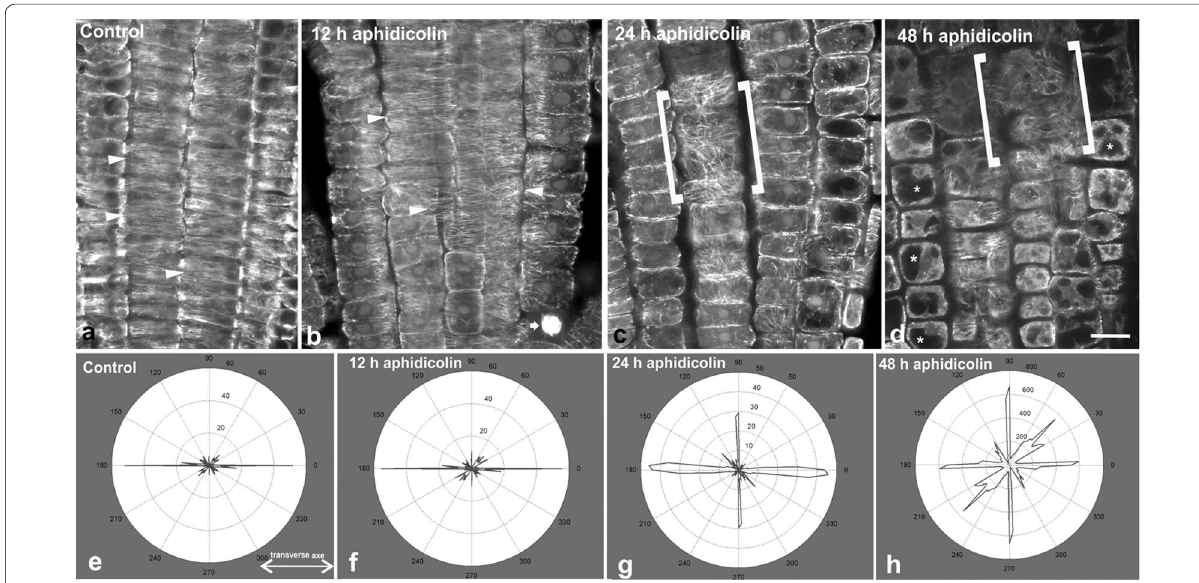
Fig. 1 Cortical microtubule orientation in the meristematic zone of untreated ( a ) and aphidicolin‑treated ( b – d ) roots. Single CLSM sections through the boundary between protoderm and cortex are presented, so that in the center of each figure cortex cells can be observed. In all the images of this work the root tip is oriented towards the bottom of the page. In control root ( a ) prominent transverse orientation of cortical microtubules can be observed in interphase cells (arrowheads). At 12 h of treatment ( b ) transverse microtubule orientation persists (arrowheads), while dividing cells still exist (arrow points to a mitotic cell). After 24 h of treatment ( c ), cell divisions have ceased and cortical microtubules exhibit random orientation (cells within the brackets are cortex cells viewed at external cortical plane), which is also observed after 48 h of treatment ( d ; cells within brackets). In the latter image, vacuolation of meristematic cells in also prominent (asterisks show vacuoles). Representative decipher‑graphs of microtubule alignment in meristematic cells of control ( e ), 12 h ( f ), 24 h ( g ) and 48 h ( h ) aphidicolin treatments. Decipher‑graphs show that microtubules are transversely oriented (doubled‑headed arrow) in the control and after 12 h of aphidicolin treatment ( e , f ), while the frequency of longitudinal and randomly oriented microtubules increased upon prolonged treatments ( g , h , respectively). Scale bar 10 μm